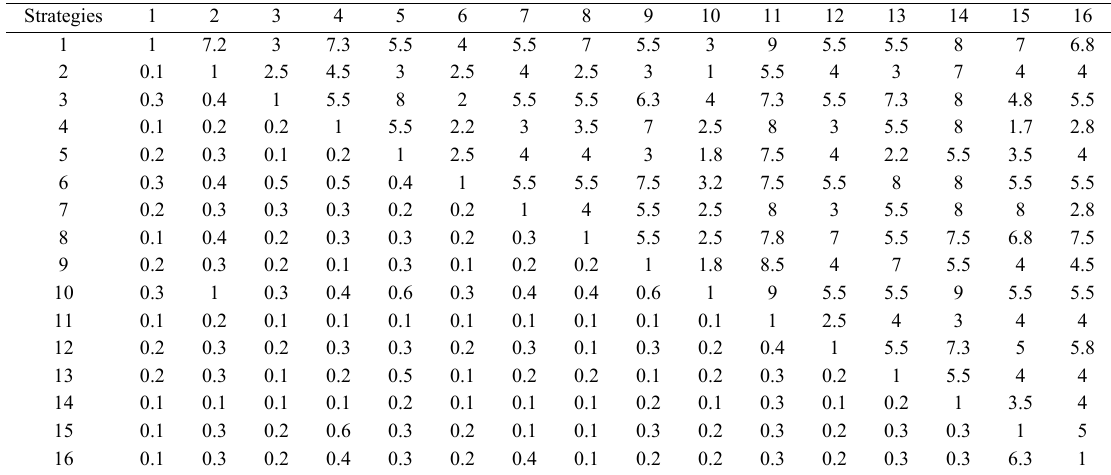
Table 5: Average of preferences of strategies for one of the petroleum districts (Tehran) Strategies